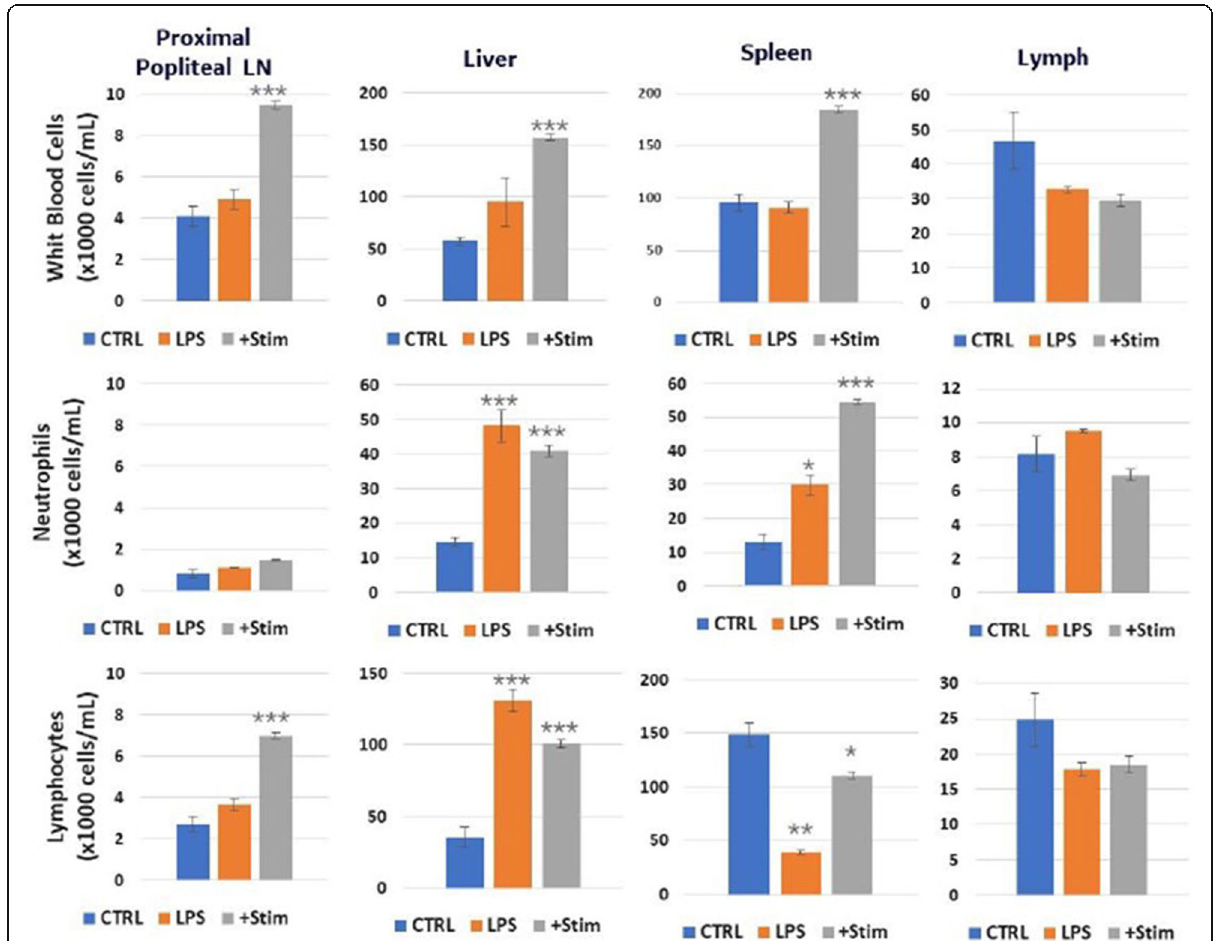
Fig. 5 White blood cell, neutrophil and lymphocyte concentrations in the directly stimulated popliteal lymph node, liver, spleen, and lymphatic duct/fluid with (LPS + Stim) or without (LPS Only) electrical sciatic nerve stimulation after pre-exposure to lipopolysaccharide (LPS) compared to no LPS/sham stimulation (CTRL) controls. N = 5. One way ANOVA with multiple comparison analysis * = p ≤ 0.05, ** = p ≤ 0.005,*** = p ≤ 0.0005; Electrical stimulation parameters: 0.5 mA, 20 Hz, pulse length 50